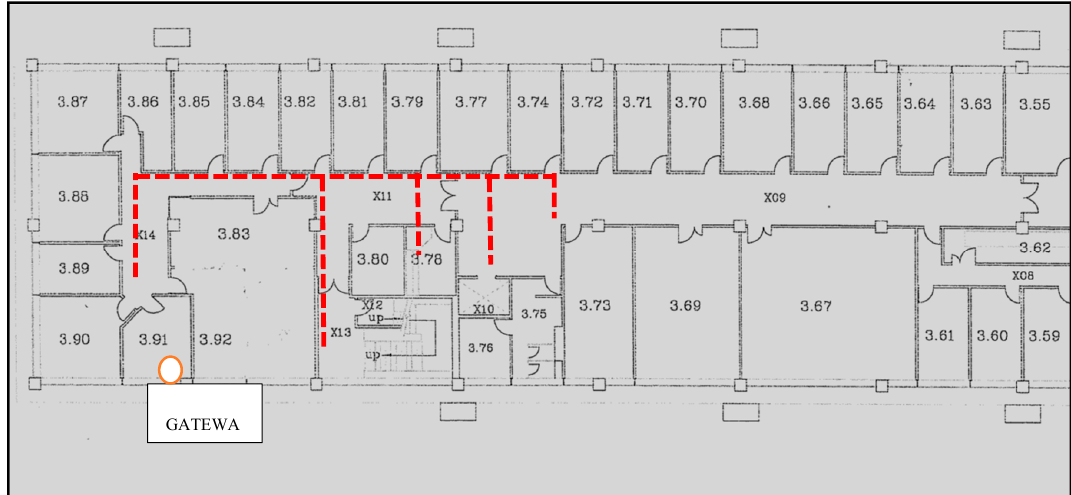
Figure 10. Traversal path of the sensor is shown in dotted red line. The distance between the sensor and the gateway is not constant.